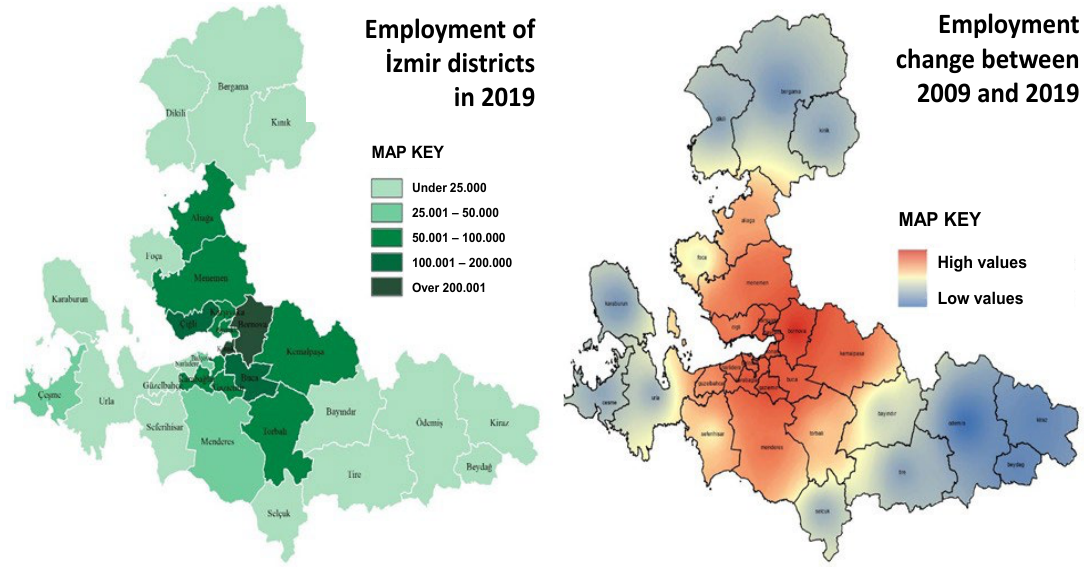
Figure 3 Employment of İzmir districts in 2019 Figure 4 Agglomeration of employment change